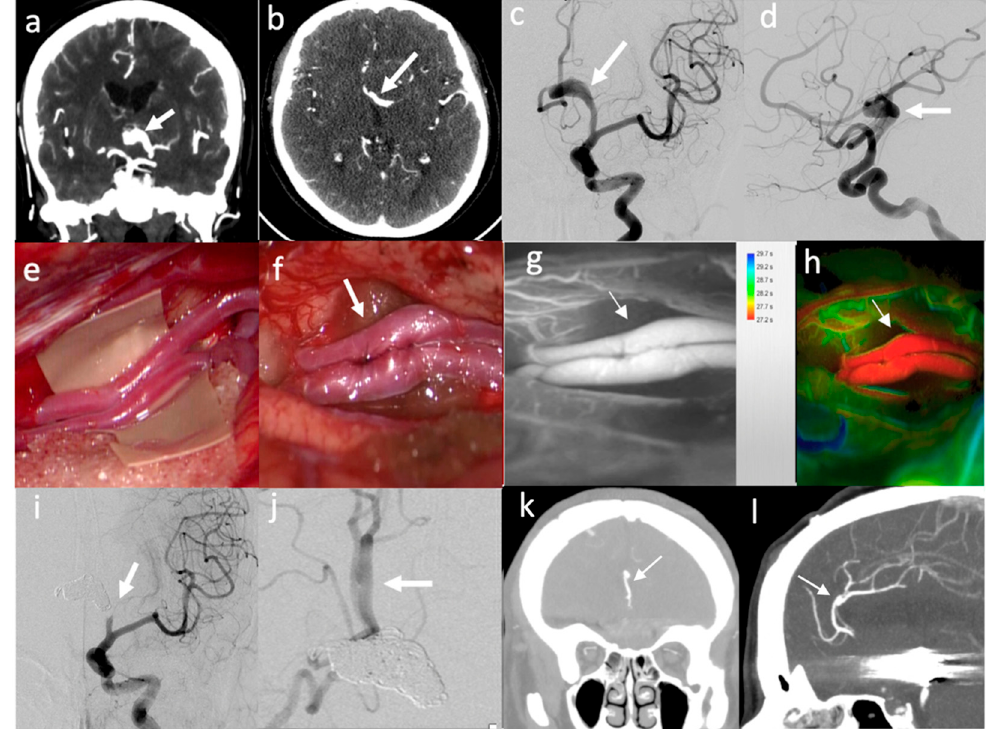
Figure 4. Illustrative case of “Complex” aneurysms with multidisciplinary treatment (bypass for flow preservation and endovascular proximal occlusion): ( a , b ) CT-angio showing large fusiform L ACA aneurysm (arrow); ( c , d ) Preoperative DSA showing L ACA aneurysm (arrow); ( e , f ) Intraoperative view of PerA–PerA latero-lateral bypass (arrow); ( g , h ) Intraoperative ICA–VA and FLOW800 analysis showing bypass patency with good perfusion (arrows); ( i ) Postoperative DSA showing endovascular aneurysm trapping with coiling; ( j ) Postoperative DSA showing PerA–PerA bypass patency with flow preservation; ( k , l ) Follow-up CT-angio showing bypass patency and aneurysm occlusion.